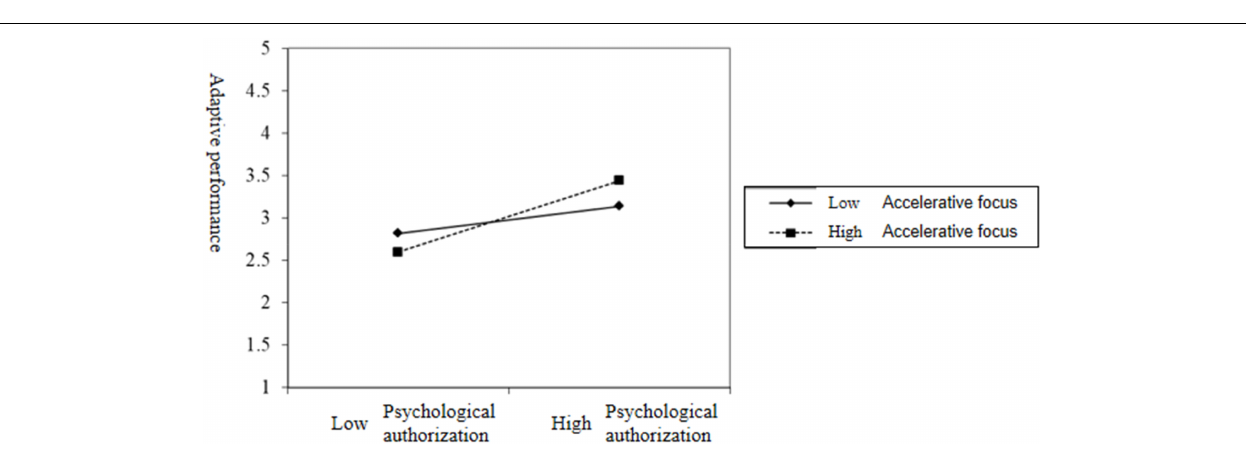
FIGURE 4 | The moderating effect of defensive regulatory focus on psychological empowerment and adaptive